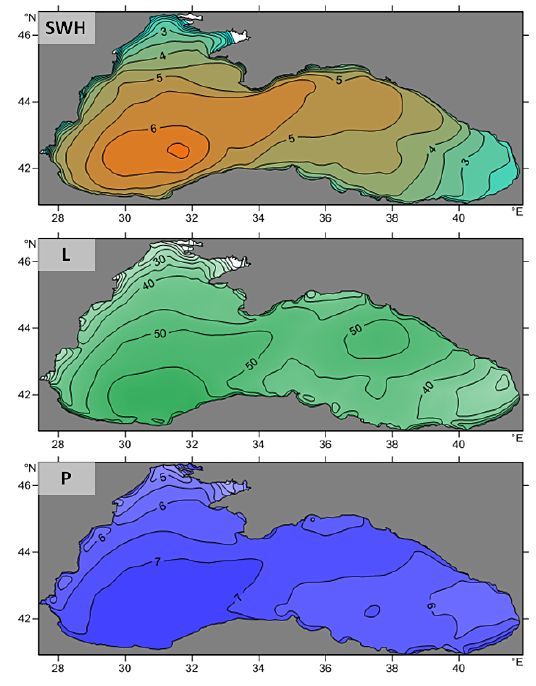
Figure 10. Maps of calculated significant wave height [m], wave length [m] and period [s] maxima in winter.